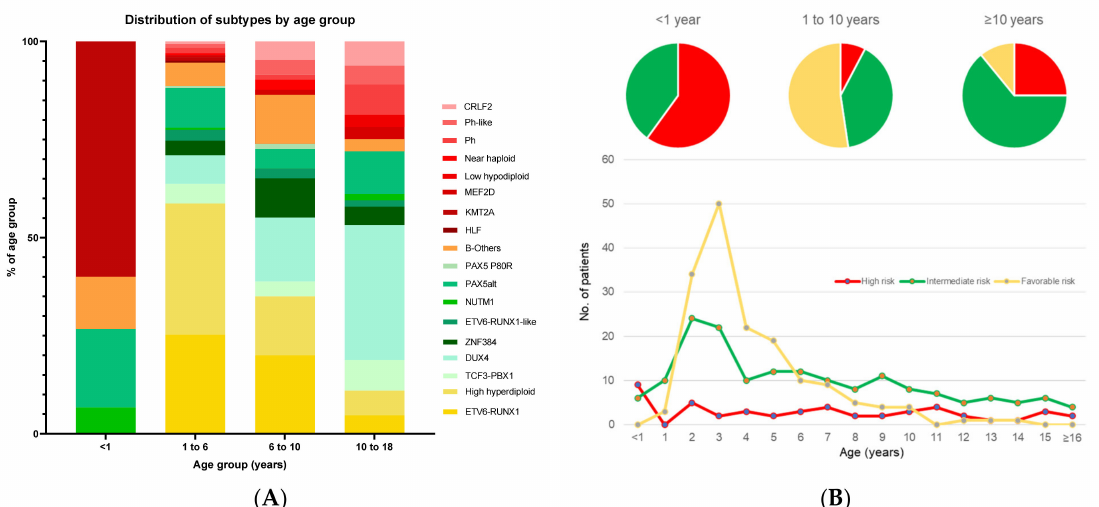
Figure 3. Association of B-cell acute lymphoblastic leukemia (B-ALL) subtypes with age. ( A ) Distribution of genetic subtypes by age group, and ( B ) distribution of genetic risk groups across ages in years. In ( A ), the proportions of individual subtypes within each age group are plotted, with subtypes summing to 100% in each category. In ( B ), the numbers of patients in each genetic risk group are plotted by age. Favorable-risk subtypes are in shades of yellow, intermediate-risk subtypes are in shades of green, and high-risk subtypes are in shades of red. B-others is depicted in orange. Here, the infant group overwhelmingly had KMT2A rearrangements with no favorable-risk genetics. This predominance of the high-risk genetics group in infants accounts for its poor outcome. After infancy, in ages 1–6 years, there is a striking peak of favorable-risk subtypes, such as ETV6-RUNX1 and high hyperdiploidy. Subsequently, the proportion of high-risk subtypes increases with age, and the converse occurs with favorable-risk subtypes. Favorable-risk genetics is rare in adolescents, where there is a predominance of intermediate- and high-risk genetics. Data are adapted from results of RNA-sequencing of children and adolescents with B-ALL in the Malaysia-Singapore